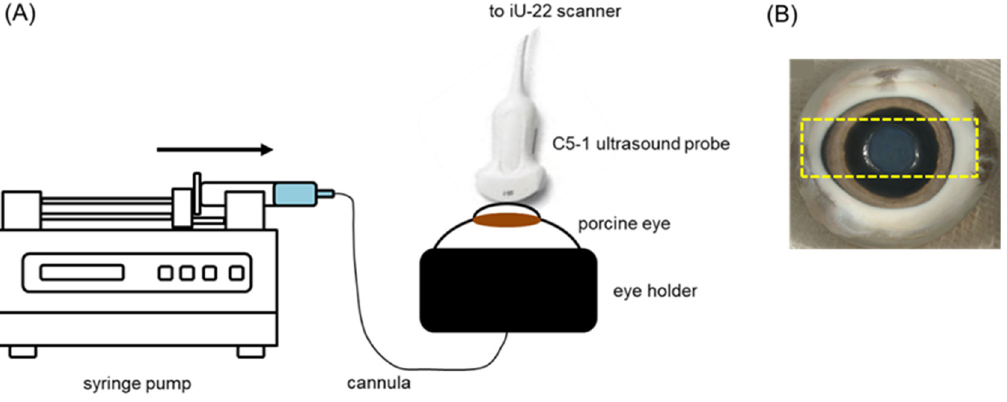
Figure 1. ( A ) Experimental setup used in USMB experiments. ( B ) Image of a porcine eye. Yellow rectangle indicates the orientation of the C5-1 probe during ultrasound imaging and USMB treat- ment.